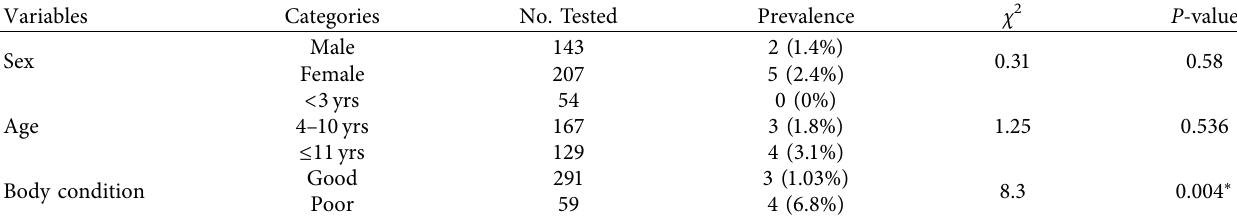
Table 3: Seroprevalence of camel brucellosis based on sex, age, and body condition using CFT as confirmatory. Variables